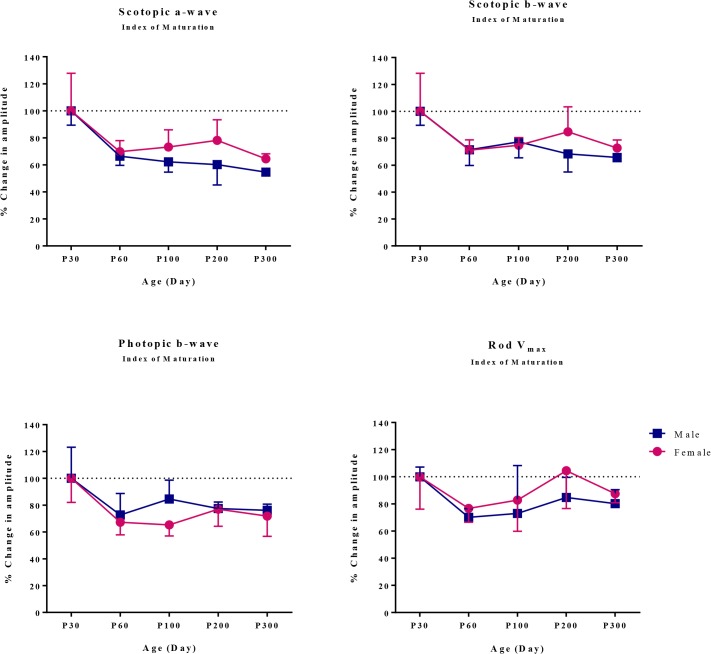
Maturation of retinal function in male and female rats (expressed of P30 value in %) at 30, 60, 100, 200 and 300 days of age.Data was normalized to P30 values. Values are given as mean ± SD.